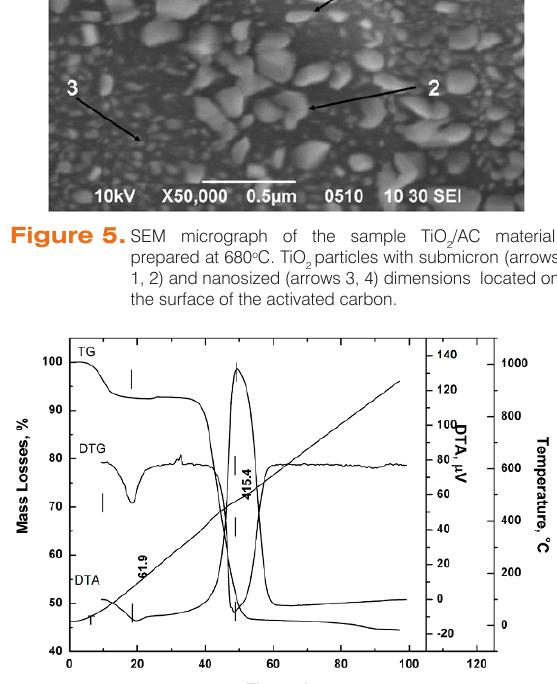
Figure 6. DTA/TG/DTG curves of TiO